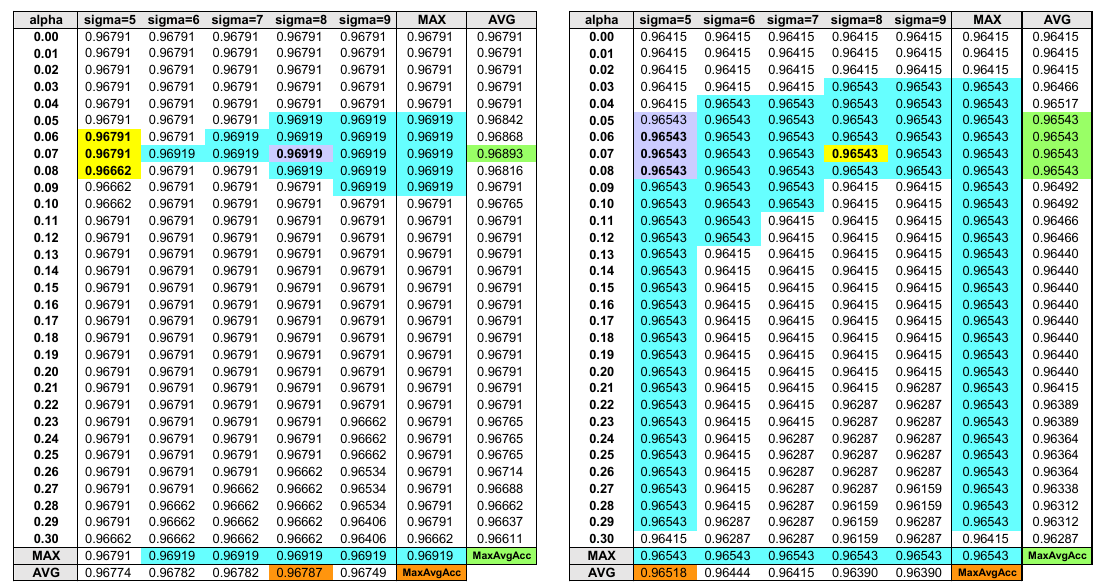
Figure 6. Validation/test data HAR accuracy using different ( σ , α ) combinations. The cyan colored cells indicate the highest activity recognition accuracy. Maximum of average accuracy (MaxAvgAcc) is searched for various average accuracies of σ and α values in order to find the suitable ( σ , α ) parameter values (orange and green colored cells). Assuming that the left table is the HAR accuracy of validation data, the purple cell where the two MaxAvgAccs meet identifies the suitable values ( σ = 8, α = 0.07). Assuming that the right table is the HAR accuracy of test data, the yellow cell at ( σ = 8, α = 0.07) achieves the highest accuracy of